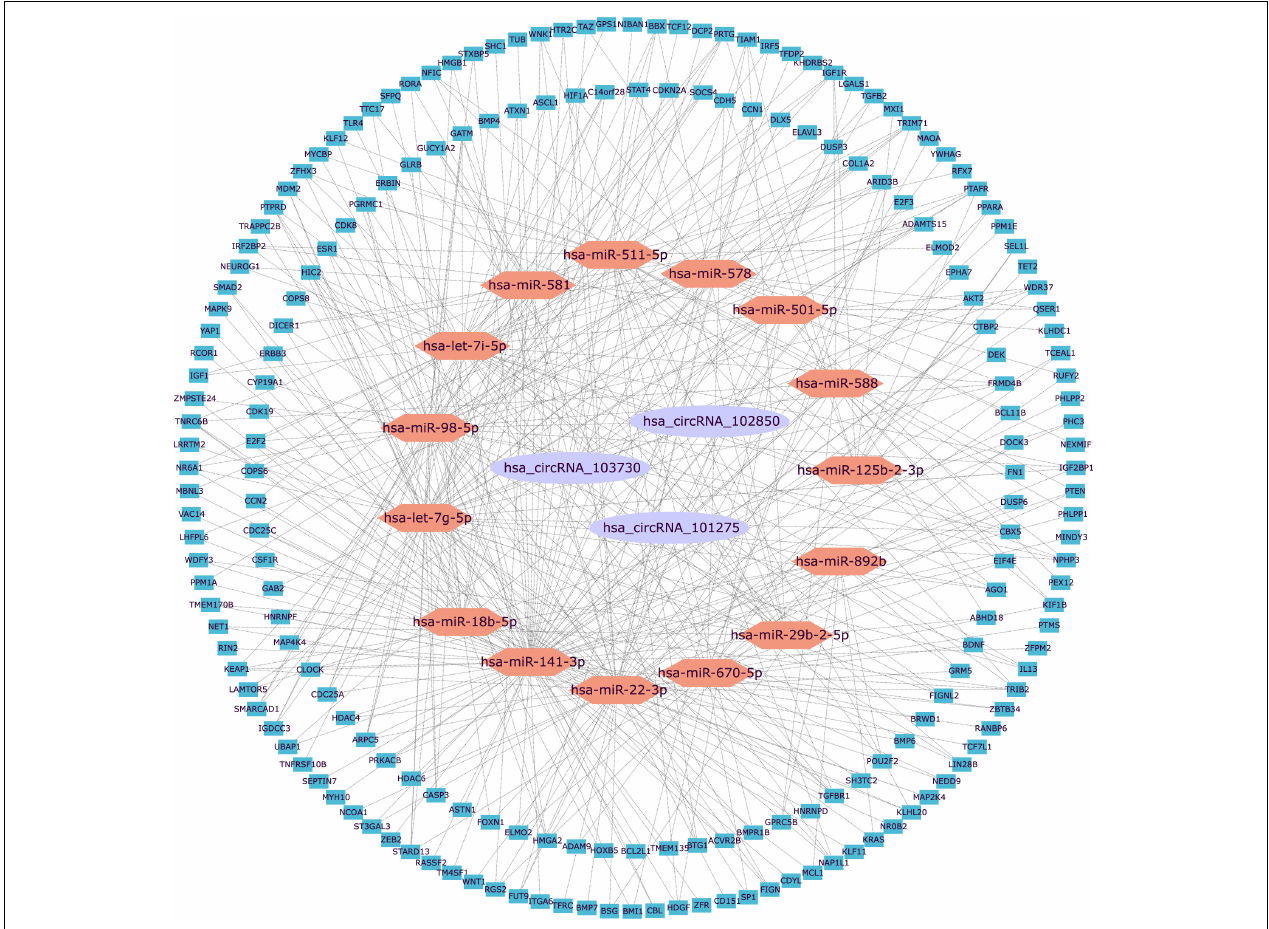
FIGURE 3 | The visualization of the circRNA–miRNA–mRNA regulation network. The circRNA–miRNA–mRNA network was constructed based on three circRNAs, 15 miRNAs, and 200 mRNAs. circRNAs were plotted as purple ellipses, miRNAs were plotted as orange hexagons, and mRNAs were plotted as blue squares. miR, microRNA; circRNA, circular